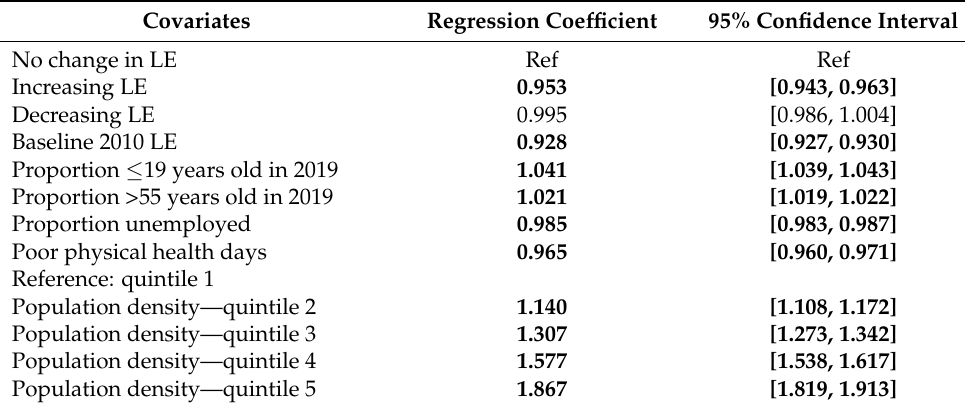
Table 4. Associations between life expectancy change and COVID-19